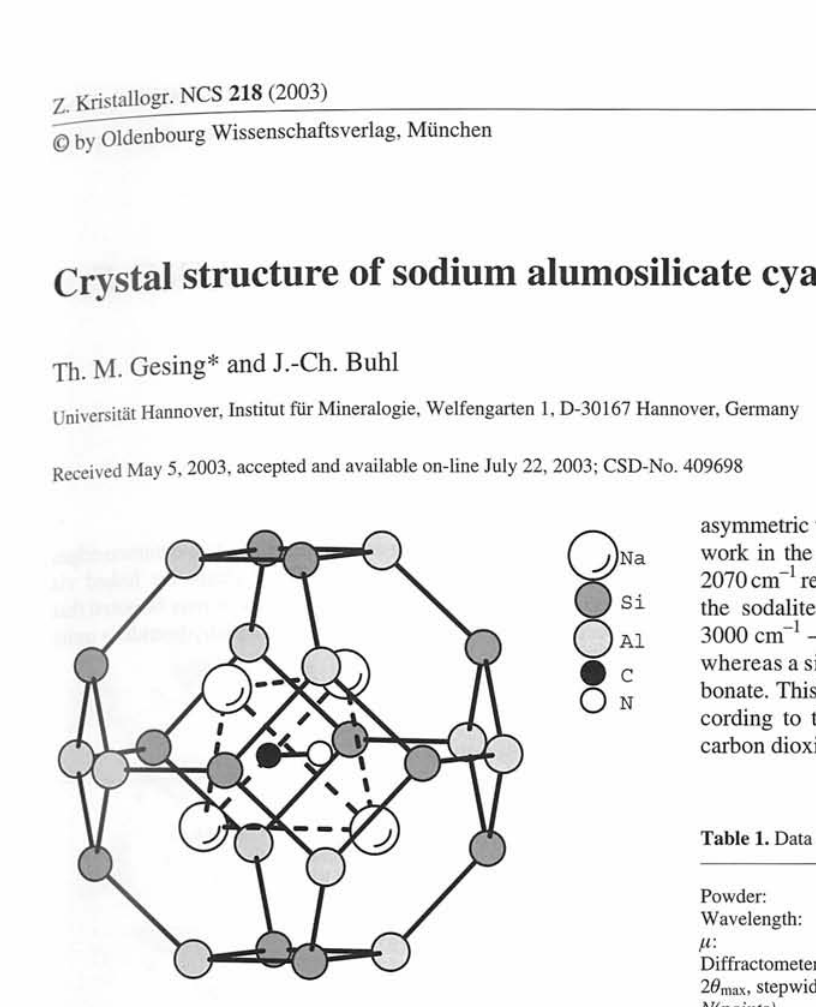
Table 1. Data collection and handling.